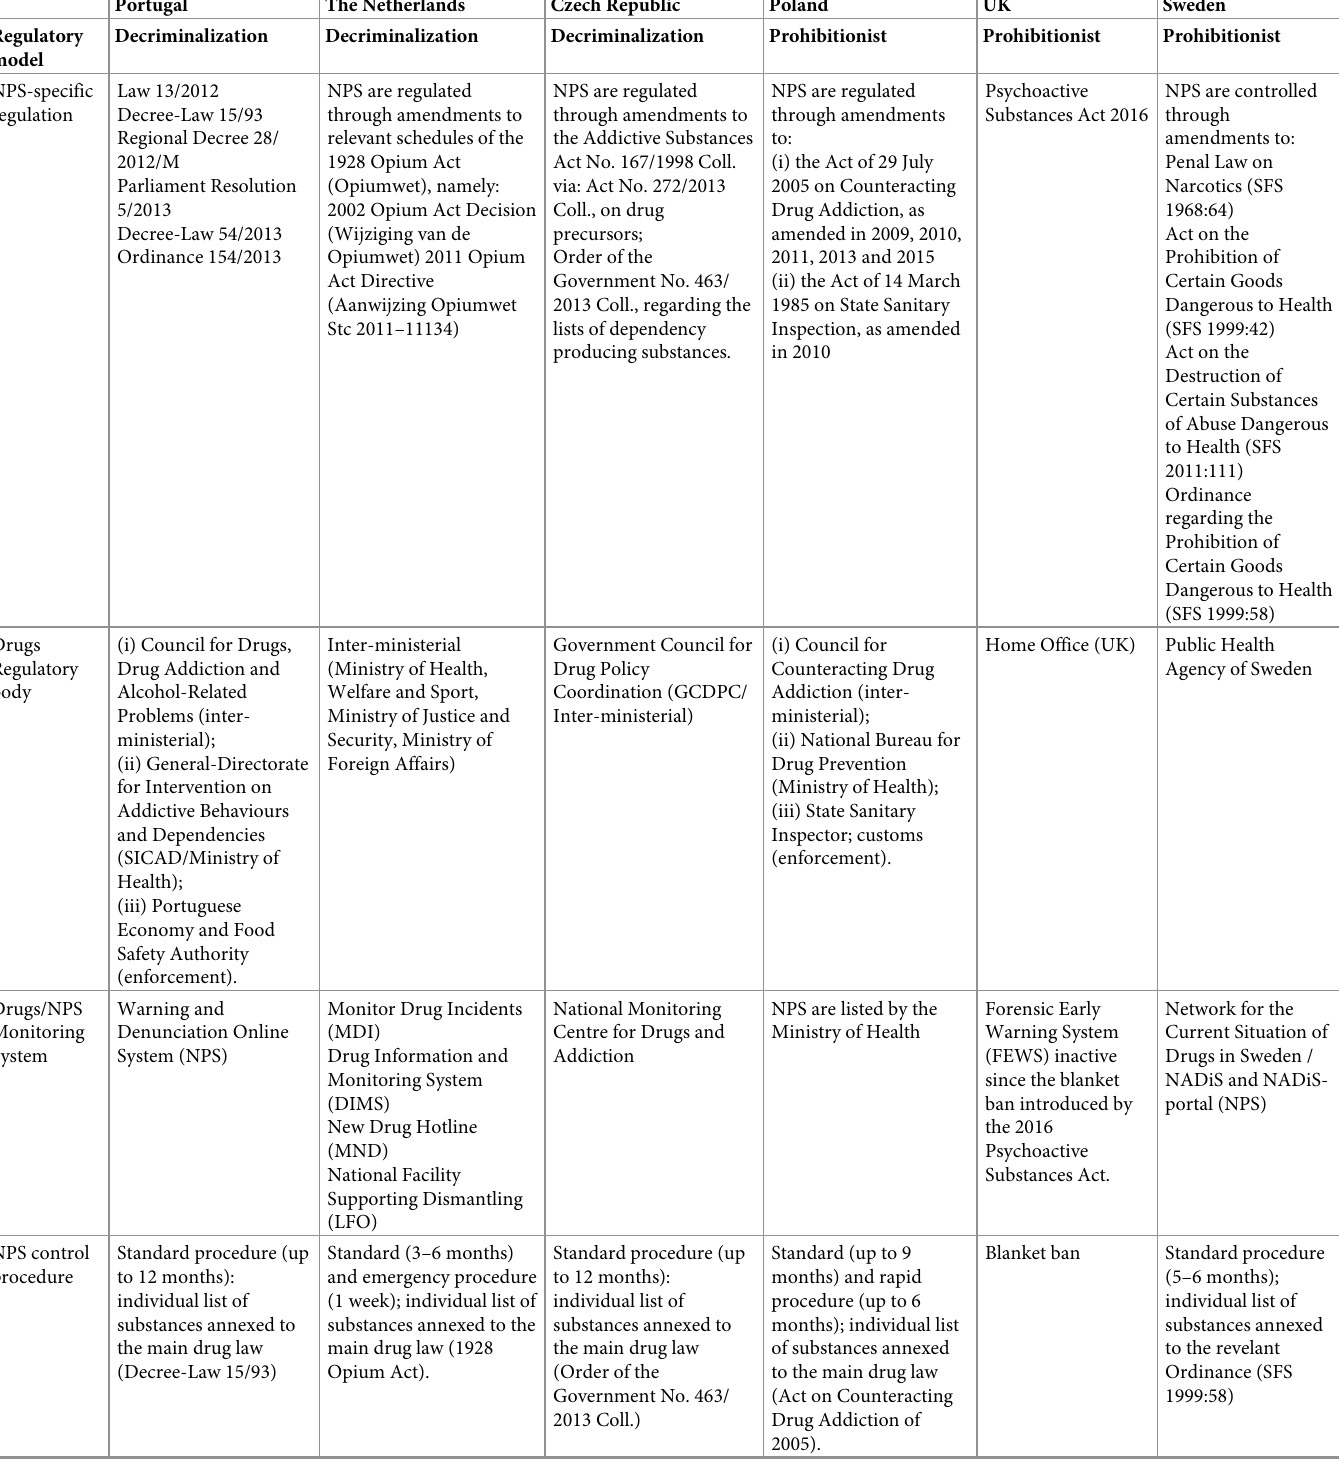
Table 1. Overview of NPS regulatory models, current national drug strategies and NPS-specific